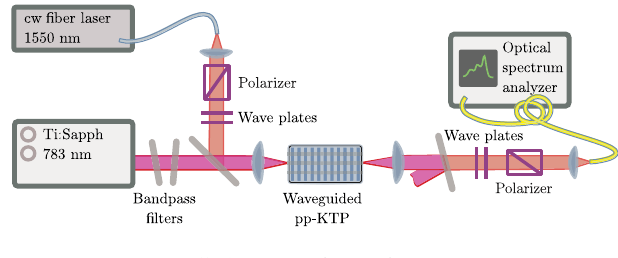
FIG. 2. Experimental setup.